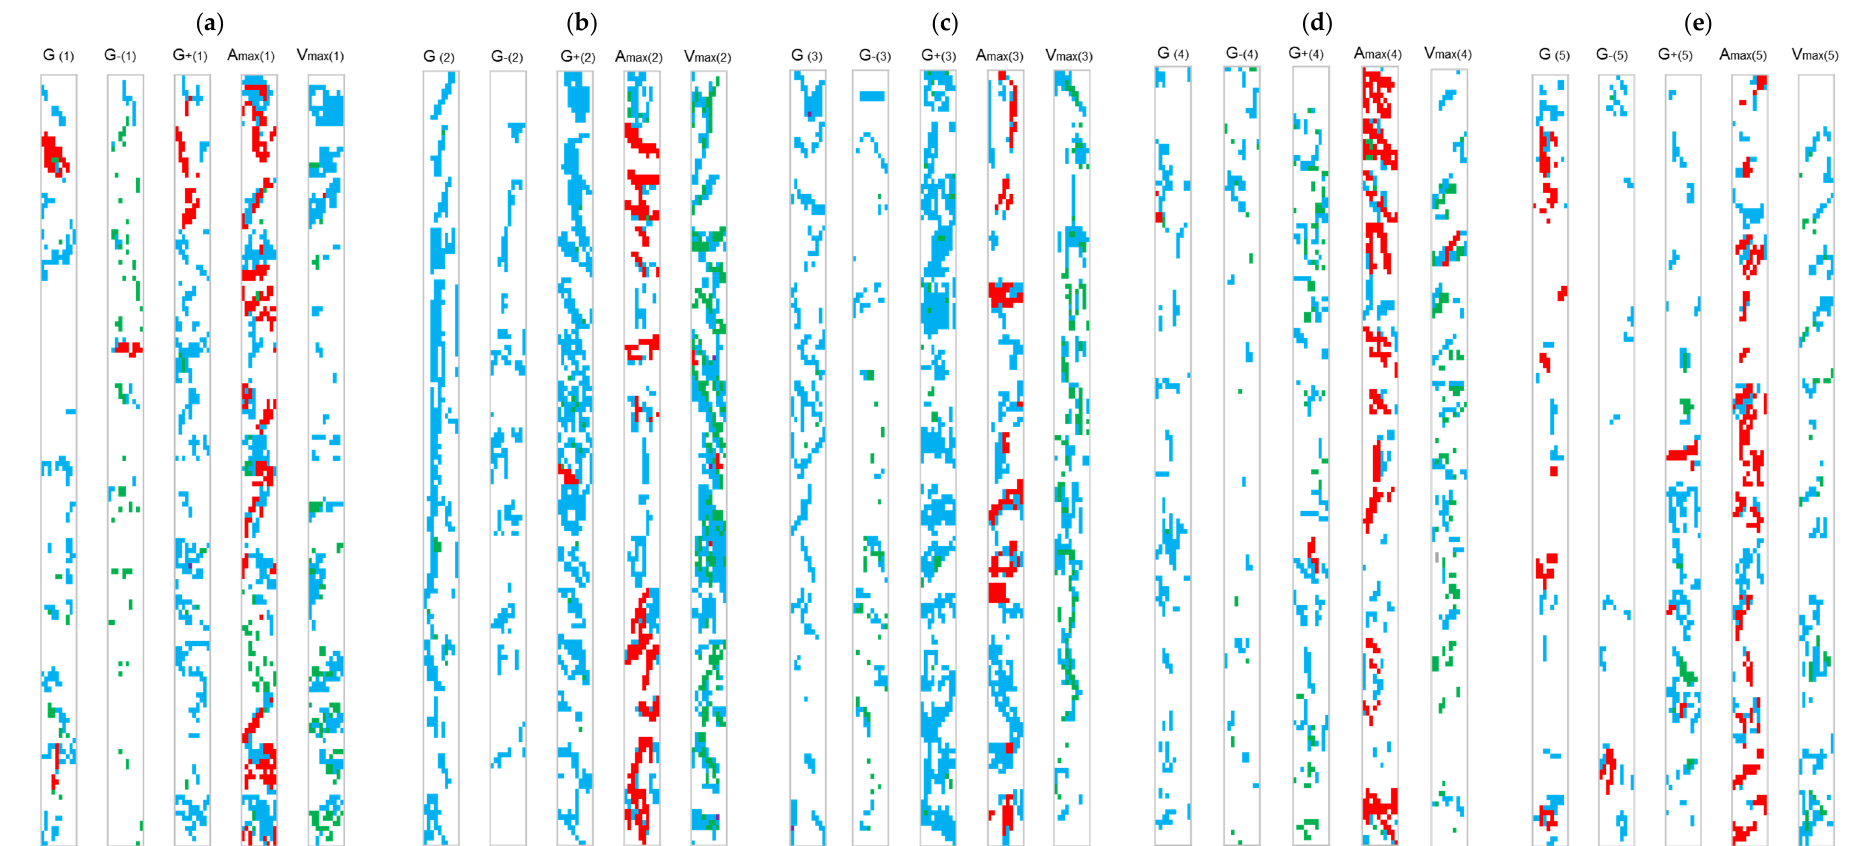
Figure 4. Mycorrhizal patterns and fungal strategy in roots of F. rubra as shaped by long-term applied treatments. ( a ) V1 (control variant)—untreated; ( b ) V2—organic (manure) treatment—10 t ha − 1 manure; ( c ) V3—low-mineral organic treatment—10 t ha − 1 manure + 50 N 25 P 2 O 5 25 K 2 O; ( d ) V4—mineral treatment—100 N 50 P 2 O 5 50 K 2 O; ( e ) V5—high-mineral organic treatment—10 t ha − 1 manure + 100 N 50 P 2 O 5 50 K 2 O. Legend to color codes and colonization strategies: blue—hyphae; red—arbuscules; green—vesicles (as detailed in Table 2). Legend to map codding: (1–5)—treatments V1 to V5; G [1–5] —general median model; G − [1–5] − ½ of general model; G +[1–5] —2× general median model; Amax [1–5] —maximum arbuscules model; Vmax [1–5] —maximum vesicles model.